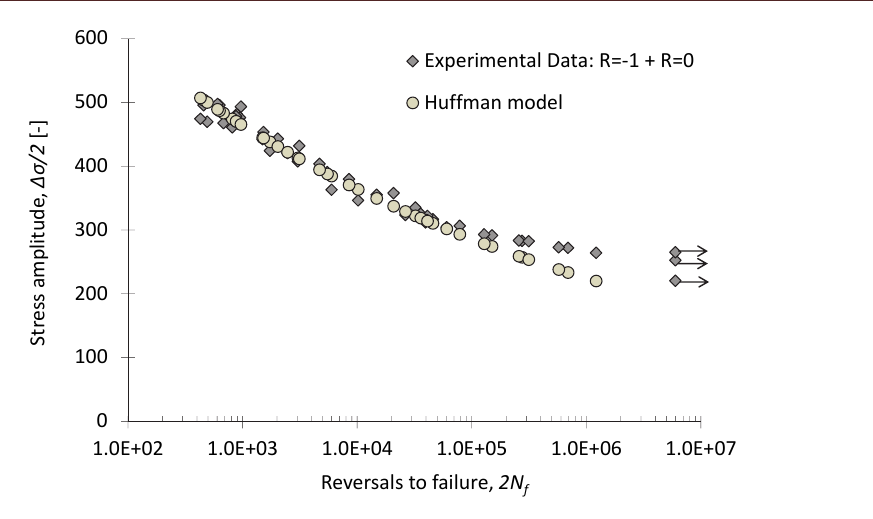
Figure 4. Stress-life curve of the P355NL1 steel, per reference [1].